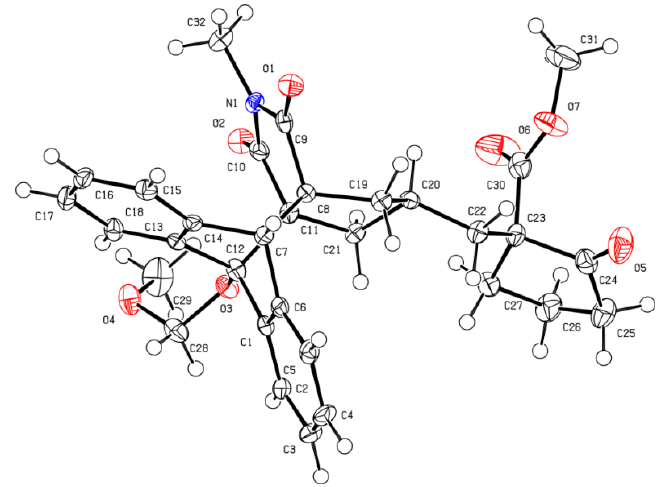
Figure 1. ORTEP representation of compound 24 .